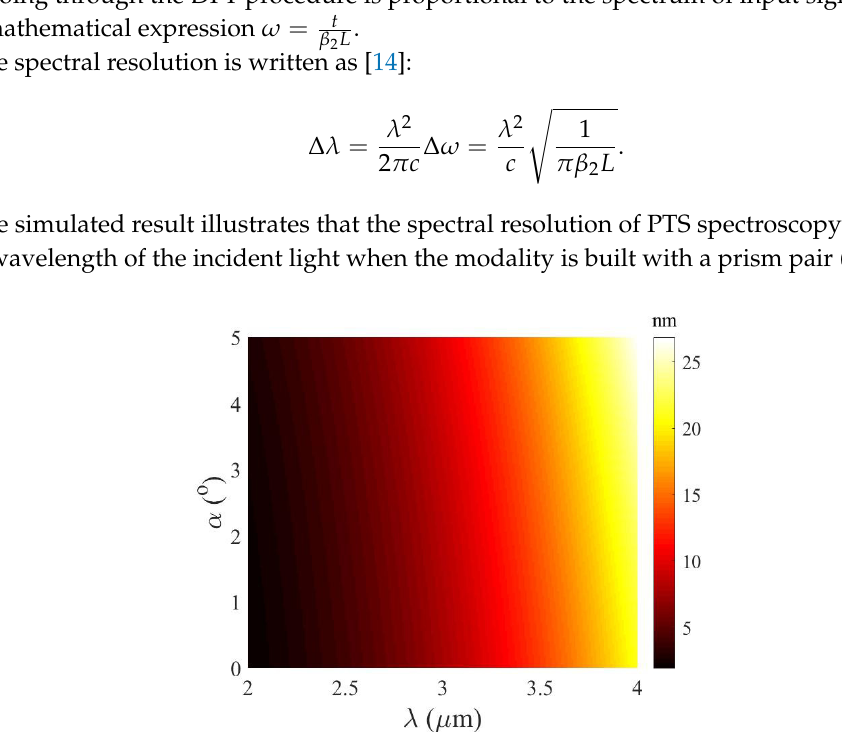
Figure 13. Spectral resolution of single-shot spectroscopy with varying light wavelength and propagation angle. The total propagation length is 15